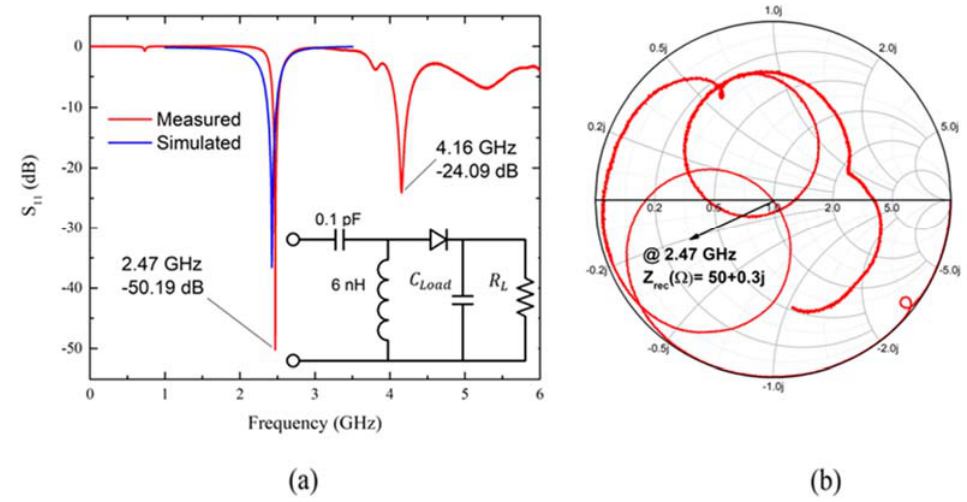
Figure 7. Measured and simulated 𝑆 (cid:2869)(cid:2869) parameter ( a ) and impedance in the Smith Chart ( b ) of a Figure 7. Measured and simulated S 11 parameter ( a ) and impedance in the Smith Chart ( b ) of a fabricated RF-rectifier prototype matched at 2.45 GHz for -30 dBm input power. Fabrication has fabricated RF-rectifier prototype matched at 2.45 GHz for -30 dBm input power. Fabrication has been done using: SMS-7630 [33], 𝐶 (cid:3013)(cid:3042)(cid:3028)(cid:3031) = 𝐶 (cid:3019)(cid:3007) + 𝐶 (cid:3046)(cid:3047)(cid:3042) being 𝐶 (cid:3019)(cid:3007) = 2.2 pF , 𝐶 (cid:3046)(cid:3047)(cid:3042) = 6.8 mF ; 𝑅 (cid:3013) = 10 kΩ been done using: SMS-7630 [33], C Load = C RF + C sto being C RF = 2.2 pF, C sto = 6.8 mF; R L = 10 k Ω and 𝐶 (cid:3040) = 0.1 pF using a CBR04C108B1GAC RF-capacitor and 𝐿 (cid:3040) = 6 nH L-07C12NJV6S RF-auto- and C m = 0.1 pF using a CBR04C108B1GAC RF-capacitor and L m = 6 nH L-07C12NJV6S RF- induction for the matching circuit. Simulated 𝑆 (cid:2869)(cid:2869) only have sense below the series resonant fre- autoinduction for the matching circuit. Simulated S 11 only have sense below the series resonant quency of the RF inductor used (3.5 GHz). frequency of the RF inductor used (3.5 GHz).